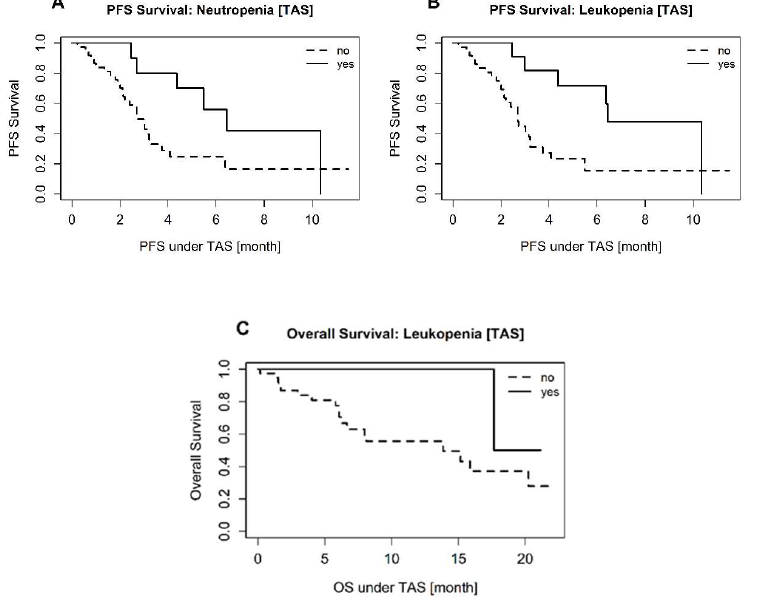
Figure 1. A + B : Kaplan–Meier curves showing progression-free survival under trifluridine/tipiracil. ( A ): KMC adjusted to neutropenia (yes or no) (log rank test: p = 0.043). ( B ): KMC adjusted to leukopenia (yes or no) (log rank test: p = 0.010). ( C ): Kaplan–Meier curves showing overall survival under trifluridine/tipiracil. KMC adjusted to leukopenia (yes or no) (log rank test: p = 0.044). Table 3. Association between progression-free survival (PFS)/overall survival (OS)/disease control rate (DCR) and adverse events with consideration of a-priori covariates in trifluridine/tipiracil. TAS